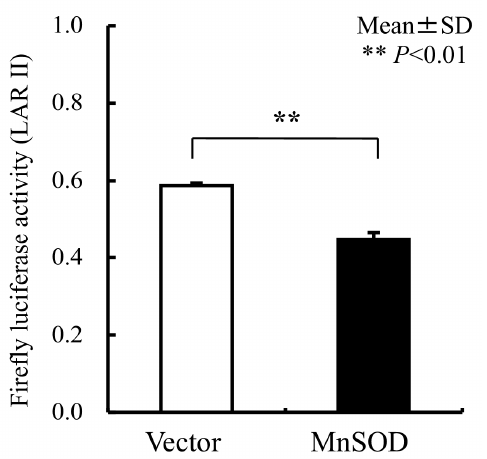
Figure 8. The results of the Luciferase reporter assay for ARE. In hMnSOD vector-transfected cells (MnSOD), the fluorescence significantly decreased compared with that in vector-alone-transfected cells (Vector), suggesting in MnSOD-transfected cells, the amounts of mtROS became lower, and, mtROS came out into cytosol from mitochondria and influenced the results of less ARE fluorescence signals. Bar: mean ± S.D.; t -test. **: p < 0 . 01 .